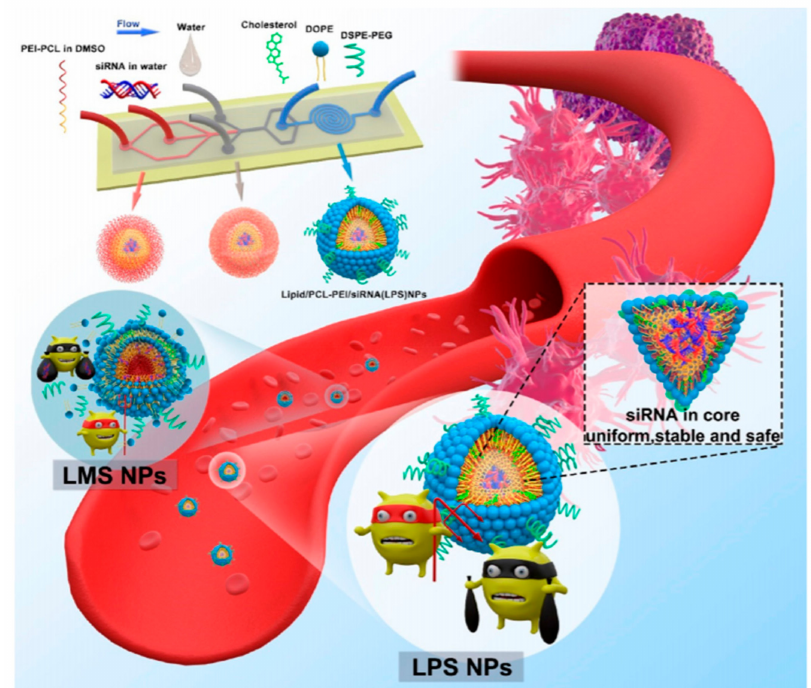
Figure 6. Schematic illustration of the preparation of LPS NPs with the aid of three-stage microfluidic technology. Reprinted with permission from Wei et al. [109]. Copyright (2020) American Chemi- cal